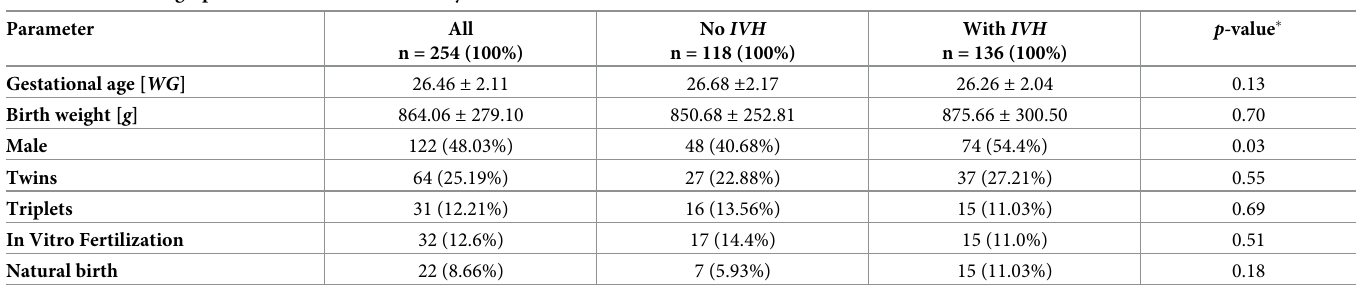
Table 1. Basic demographic characteristics of the study